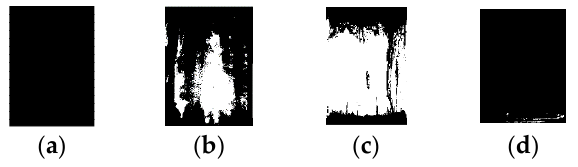
Figure 17. Binarized image of core rod after stripping sheath: ( a ) NN1; ( b ) YY1; ( c ) YN1; ( d ) NY1.